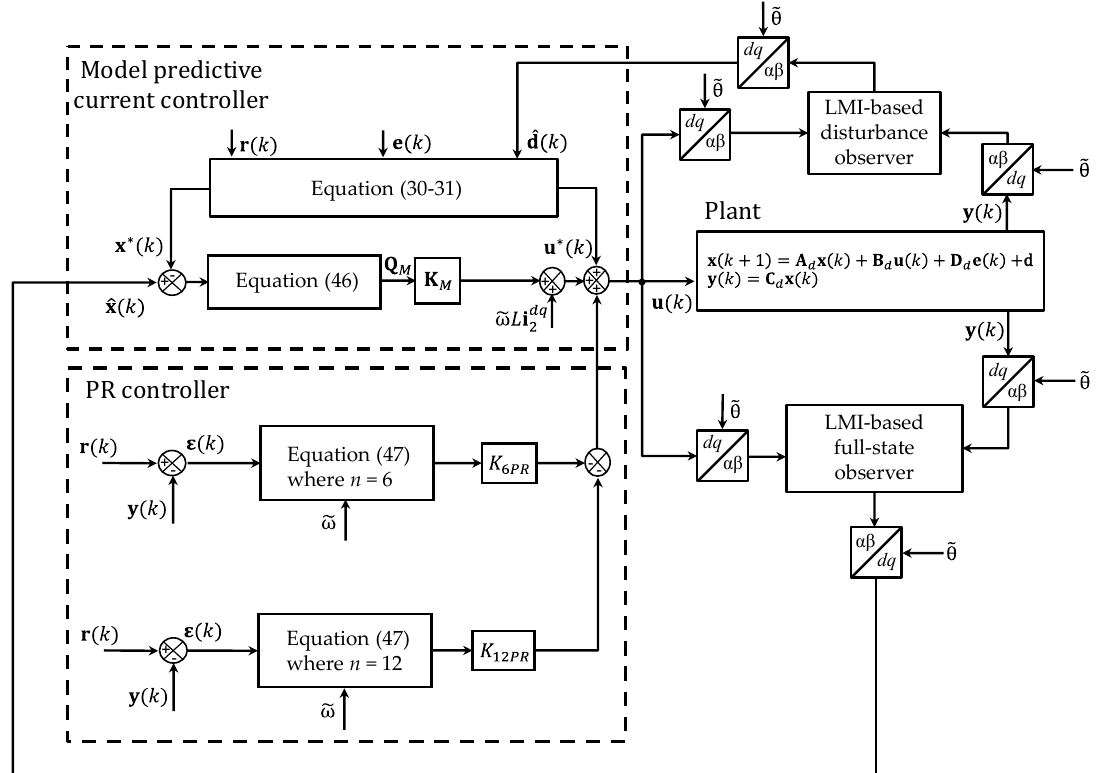
Figure 2. Block diagram of the proposed LMI-based model predictive current controller.